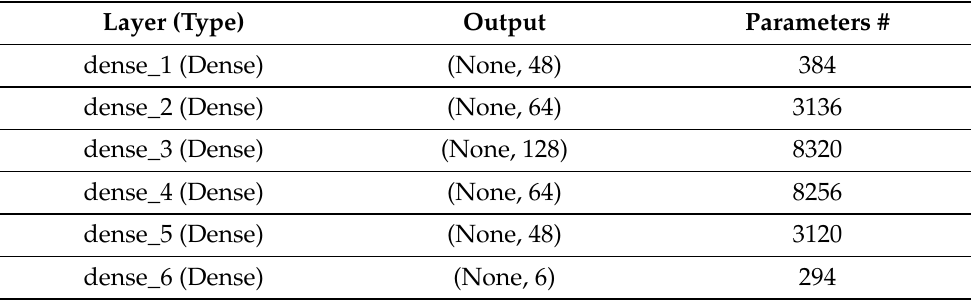
Table 4. ANN structure for the DRL decision-making model number